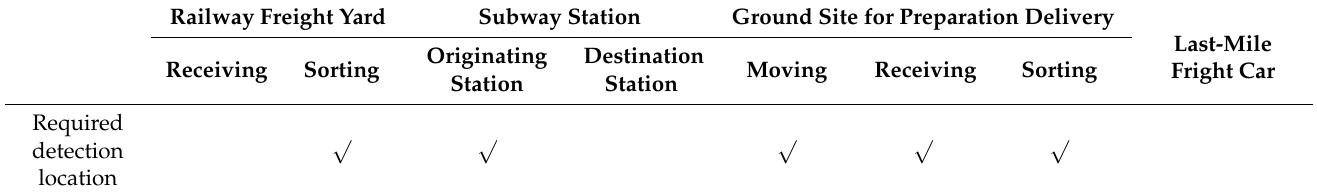
Table 1. Required detection location of parcels.